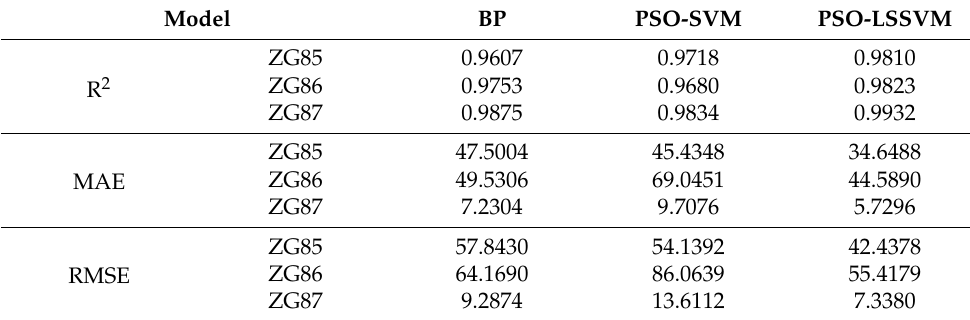
Table 4. The error of the CD of each